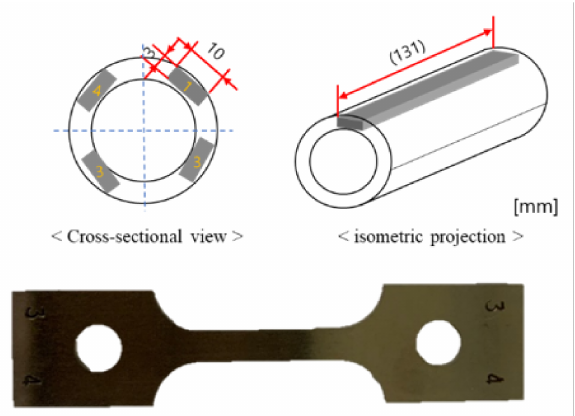
Figure 12. Specifications of the tensile test specimen, ( a ) overview, ( b ) specimen size.